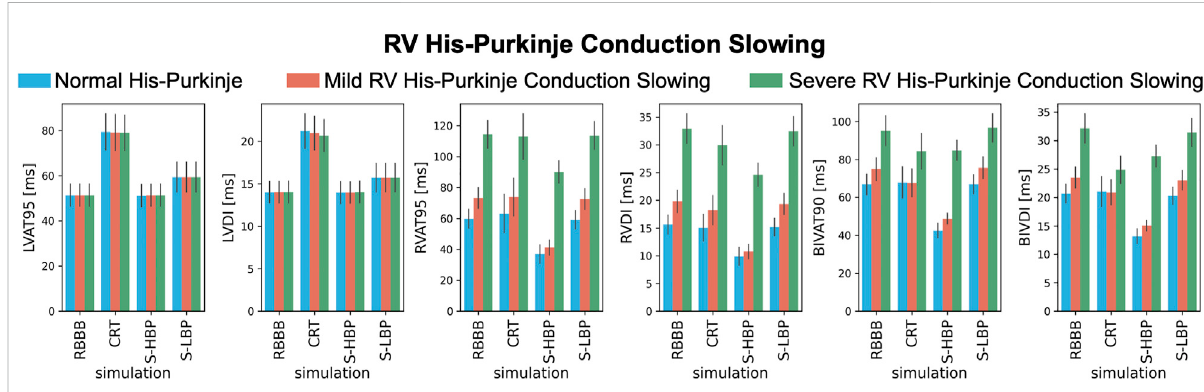
FIGURE 6 Response with RV His-Purkinje Conduction Slowing: LVAT-95, LVDI, RVAT-95, RVDI, BIVAT-90, and BIVDI simulated in the presence of proximal RBBB combined with otherwise normal His-Purkinje system (blue bars), mild (orange bars) and severe (green bars) RV His-Purkinje conductionslowing.Activationwassimulatedduring baseline,standardCRT,selectiveHBP(S-HBP)andselectiveLBP(S-LBP).Resultsarepresented as mean ± standard